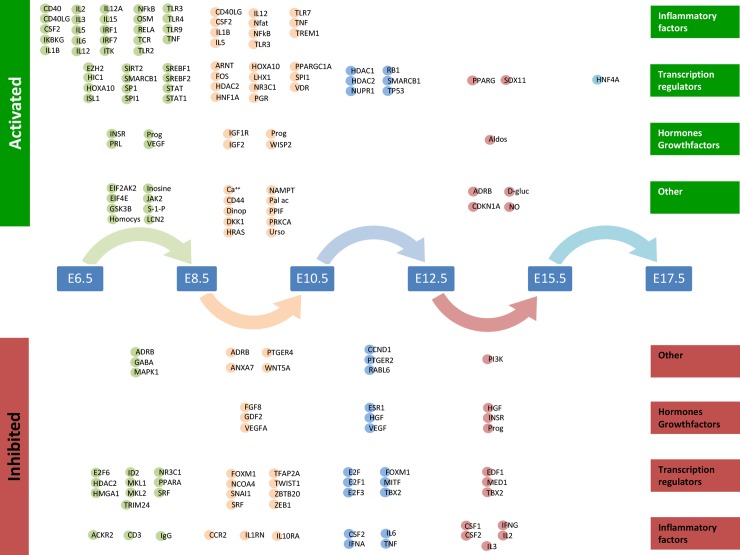
Predicted upstream regulators of differentially expressed genes between consecutive time points (DEGcts).Time window specific identification of upstream analysis of the DEGcts using Ingenuity Pathway Analysis (IPA). The coloured circles are upstream regulators identified for each comparison of consecutive time points with an activation or inhibition Z score of respectively > 2.0 or < (-2.0) (S5 Table). Circle colours correspond to colours of the arrows linking the consecutive time points. Active upstream regulators are displayed at the top of the Figure and the inhibited upstream regulators are at the bottom of the Figure. The upstream regulators are grouped into four different categories: ‘Inflammatory factors’, ‘Transcription regulators’, ‘Hormones and growth factors’ and ‘Other’. Aldos = Aldosterone, D-gluc = D-glucose, Dinop = Dinoprost, Homocys = Homocysteine, NO = Nitric oxide, Pal ac = Palmitic acid, Prog = Progesterone, S-1-P = Shingosine-1-phosphate, Urso = Ursodeoxycholic acid.